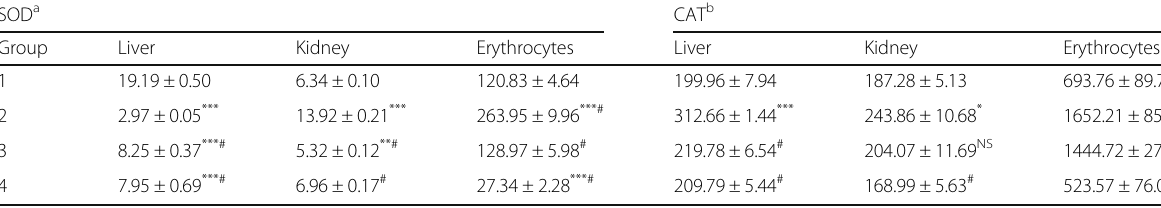
Table 6 Effect of HIE on SOD and CAT in STZ induced diabetic mice SOD